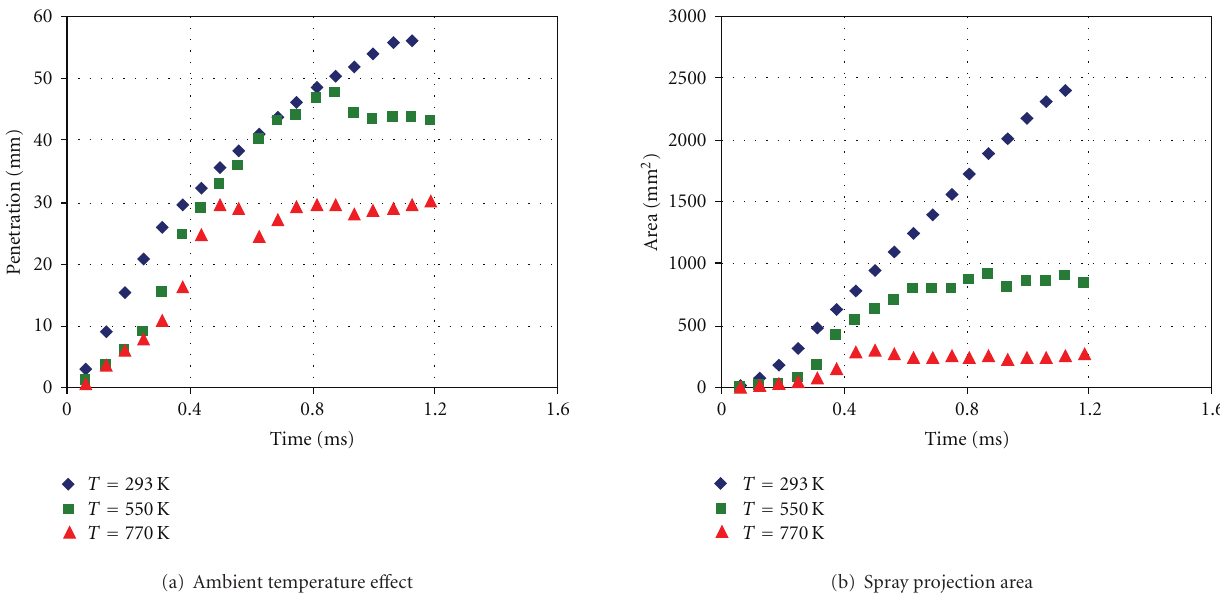
Figure 15: Ambient temperature e ff ect on (a) spray liquid penetration and (b) spray projection area (experimental results obtained with Nozzle B, at 3MPa ambient pressure, 50 MPa injection pressure, 1.5ms injection duration).